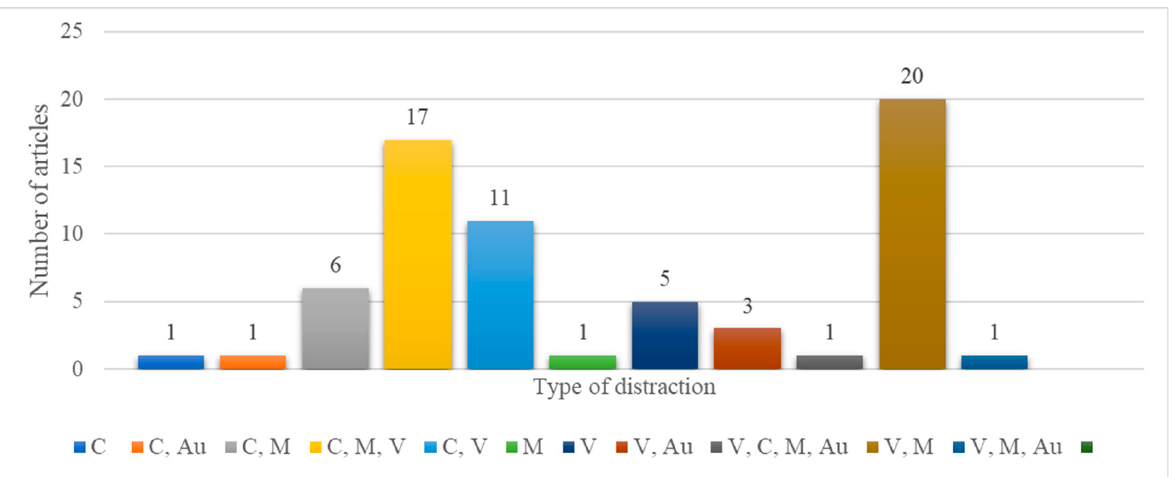
Figure 6. Distribution of papers by the source of distraction type (V—visual; Au—auditory; M— manual (physical); and C—cognitive). M—manual (physical); and